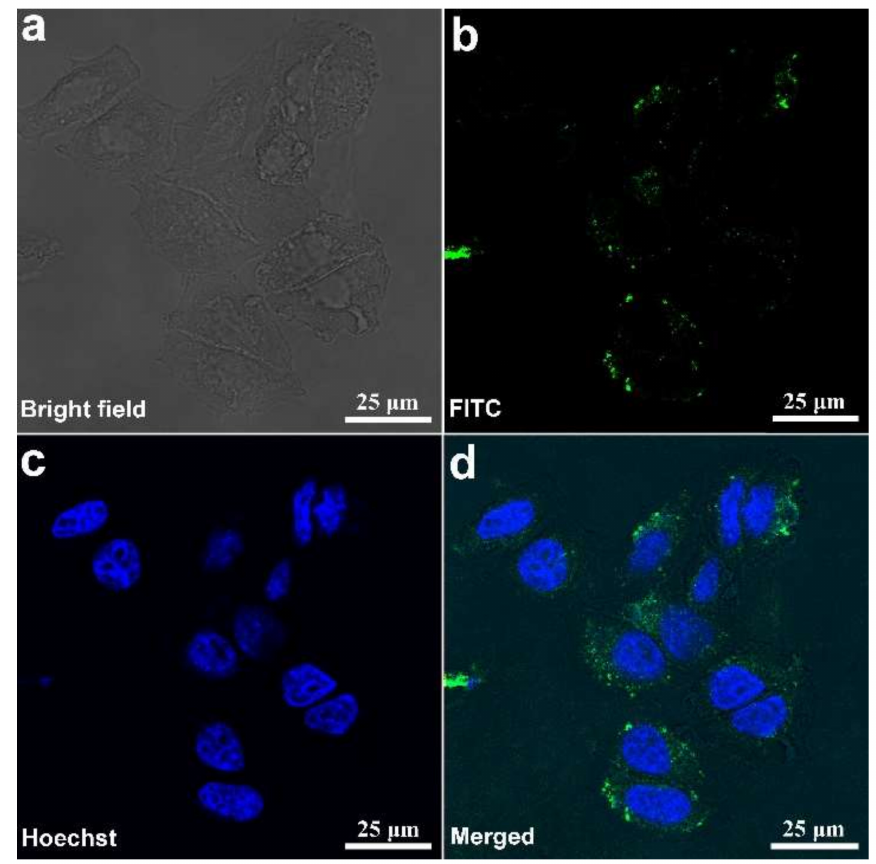
Figure 8. LSCM images of HL-7702 cells after incubation with FITC-labeled MSNs-SS-DMSA for 6